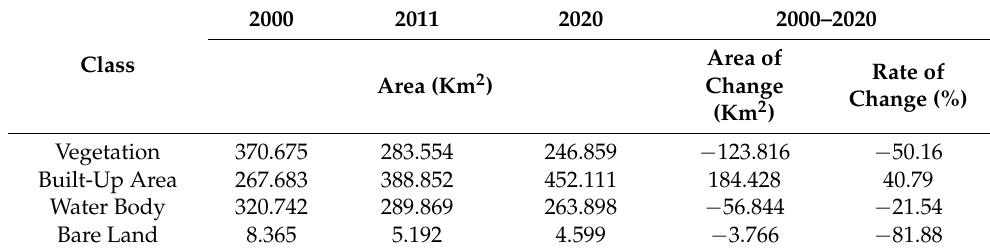
Table 3. Changes in LULC class from 2000 to